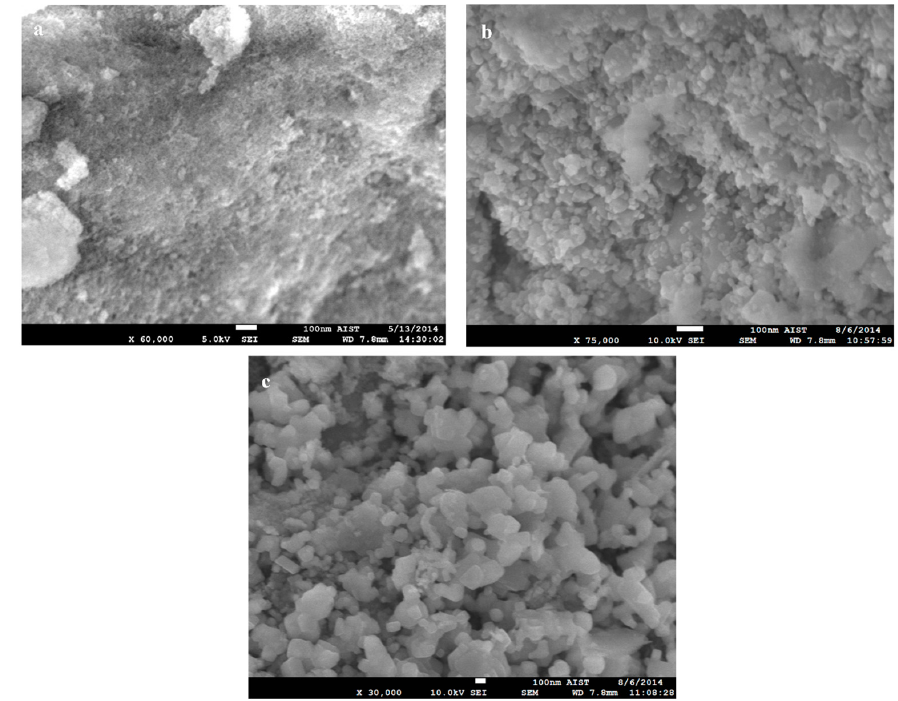
Figure 4. Scanning electron microscopy (SEM) micrograph of Ni 0.5 -Cu 0.5 /Al 2 O 3 catalysts with various Ni-Cu content ratios: ( a ) 6 wt. % Ni 0.5 -Cu 0.5 / γ -Al 2 O 3 , ( b ) 18 wt. % Ni 0.5 -Cu 0.5 / γ -Al 2 O 3 , ( c ) 36 wt. % Ni 0.5 -Cu 0.5 / γ -Al 2 O 3 .